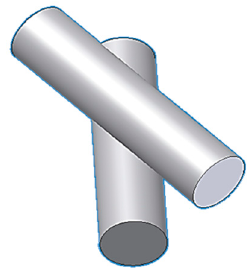
Figure 23. Test configuration–position of cylinders with respect to each other.